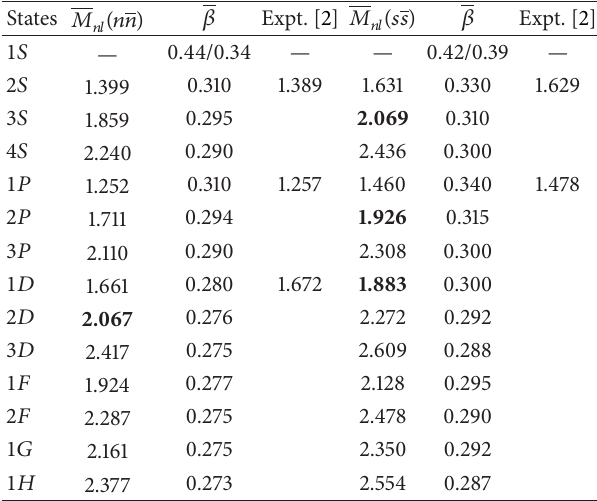
Table 1: The spin-averaged mass (unit: GeV) and the harmonic oscillator parameter 𝛽 (unit: GeV − 1 ) of the states 2𝑆 , 3𝑆 , 4𝑆 , 1𝑃 , 2𝑃 , 3𝑃 , 1𝐷 , 2𝐷 , 3𝐷 , 1𝐹 , 2𝐹 , 1𝐺 , and 1𝐻